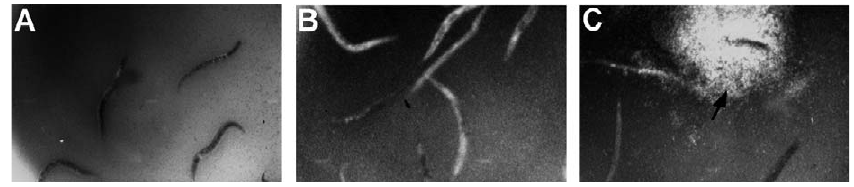
Figure 7. Phenotypic Assay Detects Compounds with Antifungal Activity After exposure to strain C. albicans MLR62, C. elegans glp-4;sek-1 nematodes were pipetted into 96-well plates that contained compounds from chemical libraries. Nematodes exposed to compounds that had antifungal efficacy (in this case, CAPE) had no fluorescence within the intestine (A), whereas nematodes exposed to compounds without antifungal efficacy did not demonstrate any movement (B) and developed filaments outside the nematodes (C). Roughly 25 worms were used per